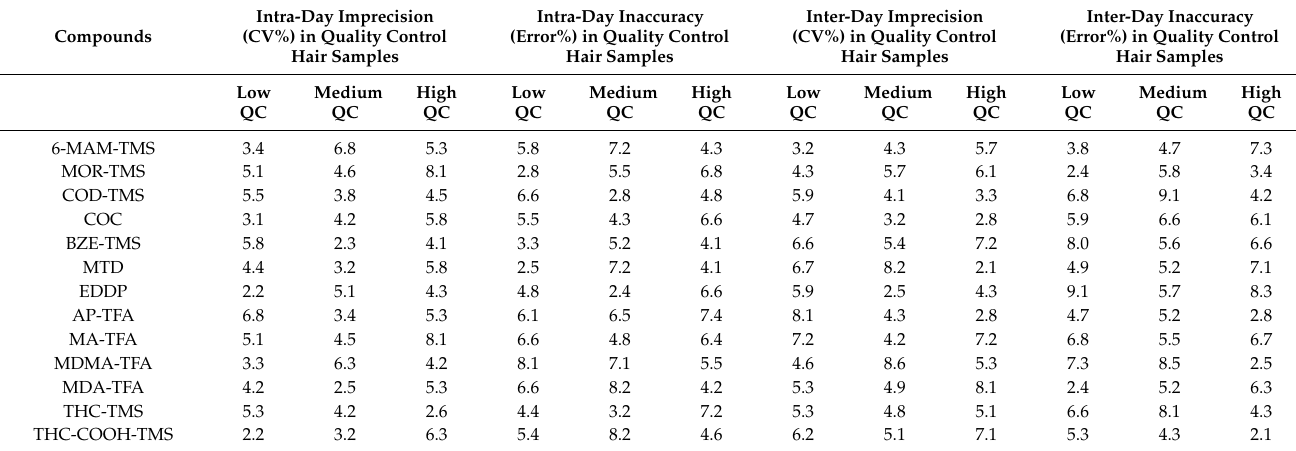
Table 3. Intra-day ( n = 5) and inter-day ( n = 15) imprecision and inaccuracy for analytes under investigation.